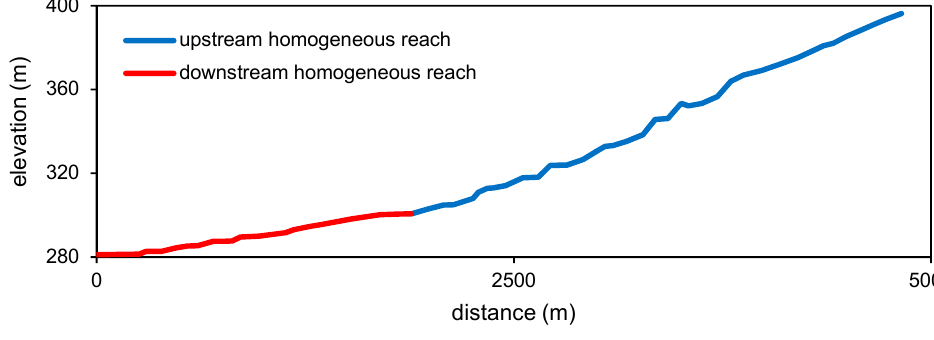
Figure 7. Homogeneous reaches in the longitudinal profile of the river bed.